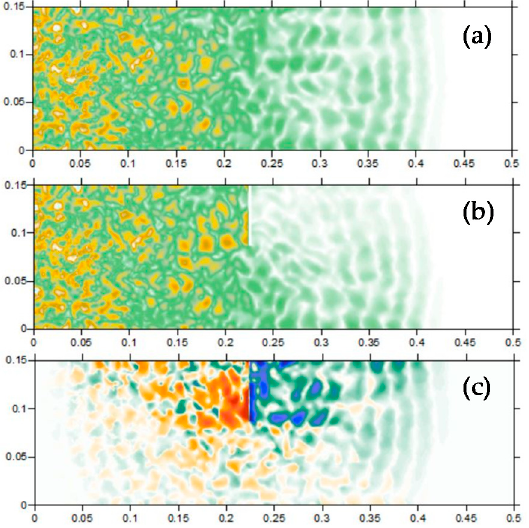
Figure 6. Wave field in the random aggregates models: ( a ) healthy beam; ( b ) damaged beam; ( c ) The difference wave field of the healthy and damaged beam.